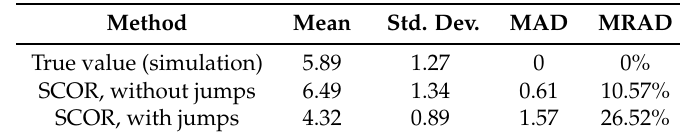
Table 3. Statistics for the risk margin on the 500 simulated triangles. The average risk margin, the standard deviation of the risk margin around the average and the mean absolute and relative deviation (MAD/MRAD) from the true value are displayed.